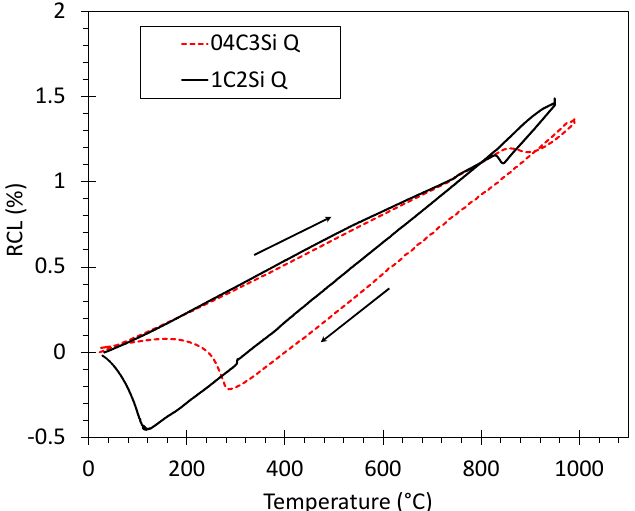
Figure 2. Relative change in length (RCL) as a function of T during quench (Q) experiments consisting of heating up to selected austenitization temperature at 5 ◦ C/s and subsequent cooling down to room temperature at 15 ◦